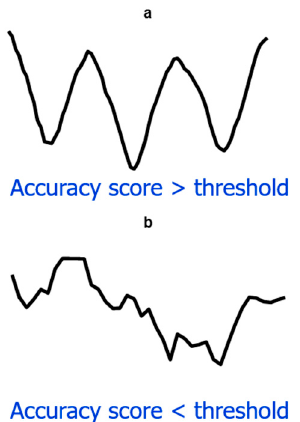
Figure 13. Pattern classified by SVM as HR ( a ) or anomaly pattern ( b ) based on accuracy score.